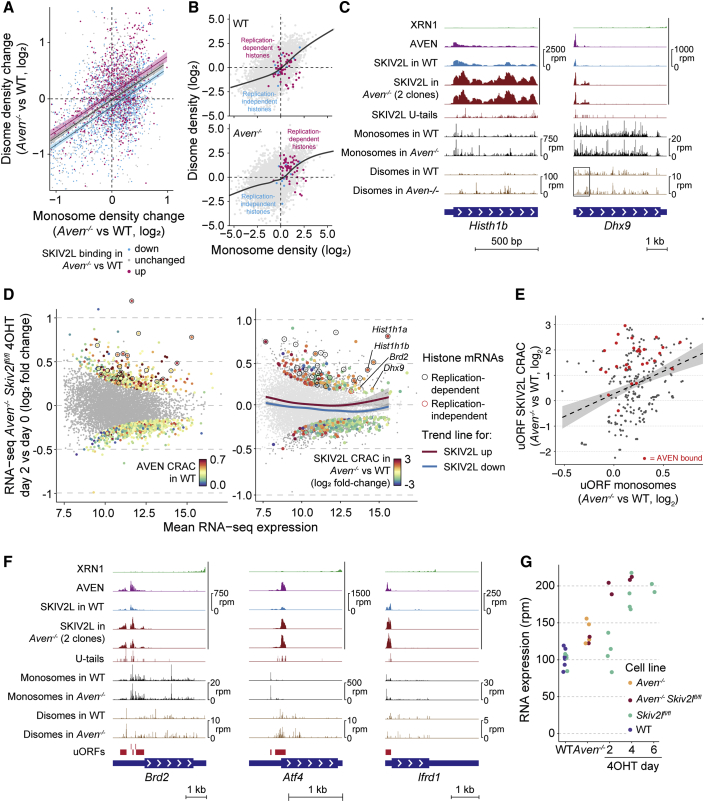
AVEN and SKIV2L Counteract Ribosome Stalling(A) Changes in mRNA monosome and disome densities in Aven−/− versus WT. Transcripts are colored by changes in SKIV2L binding in Aven−/− versus WT (threshold log2 fold change = ±0.5; up, n = 1,856; down, n = 2,019; unchanged, n = 2,373), and a linear best fit is plotted for each group (shaded area represents 95% confidence interval).(B) Monosome and disome densities in WT (top) and Aven−/− (bottom), highlighting histone mRNAs and with a cubic regression trendline.(C) CRAC and monosome/disome profiling for individual mRNAs.(D) Changes in mRNA abundance for Skiv2lfl/flAven−/− cells after 2-day 4-OHT. Significantly changing mRNAs (padj < 0.05) colored by AVEN CRAC in WT (left) or SKIV2L CRAC changes in Aven−/− versus WT (right). Cubic regression trendlines are shown for all mRNAs, grouped by increased/decreased SKIV2L binding in Aven−/− versus WT (right).(E) Changes in uORF SKIV2L CRAC and monosome profiling counts for Aven−/− versus WT cells. Both datasets normalized to main CDS monosome profiling counts. A best-fit line is shown, with 95% confidence intervals, and AVEN-bound uORFs (defined in Figure S4E) are colored red.(F) CRAC and monosome/disome profiling for individual mRNAs. uORFs identified from monosome profiling are shown in red.(G) RNA-seq counts for Ifrd1 in various cell lines showing individual replicates.See also Figure S4 and Tables S3 and S4.